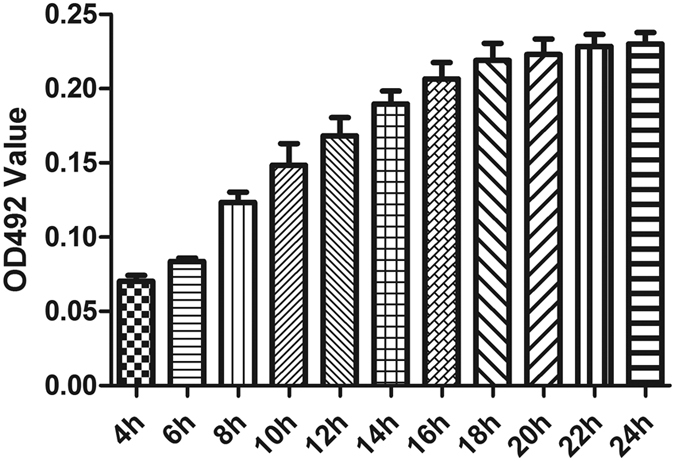
Average ODs at different time points (hours) of 15 randomly* selected S. maltophilia isolates.Results are means ± SDs. *Included 7 strong, 6 moderate and 2 weak biofilm producers.